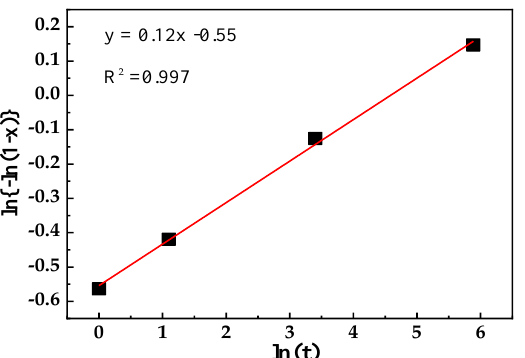
Figure 8. The ln{ − ln(1 − x )} vs. ln( t ) curve to determine the Avrami exponent of the specimens annealed at 675 ◦ C for di ff erent